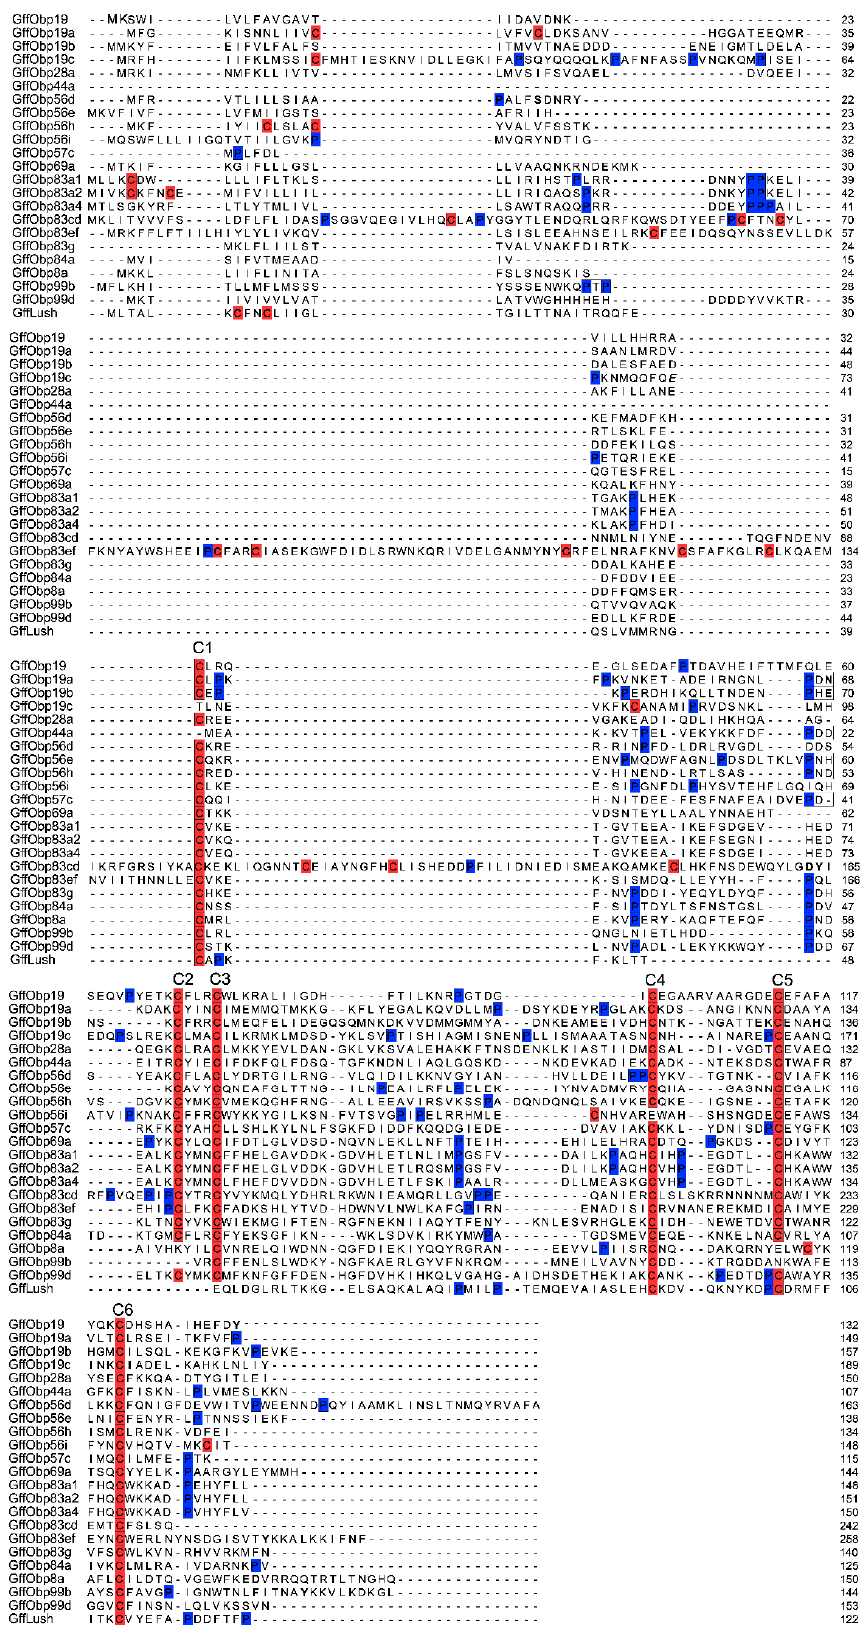
Figure 1. Multiple alignments of G. fuscipes fuscipes odorant-binding protein genes. Conserved cysteines are highlighted in red and proline residues in